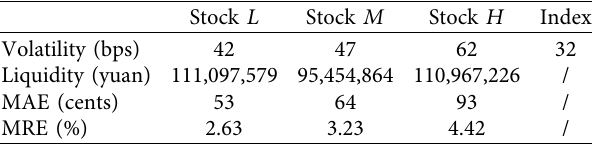
Figure 1: Dynamics index price of the spot market benchmark model. Table 6: Market quality analysis using the spot market benchmark